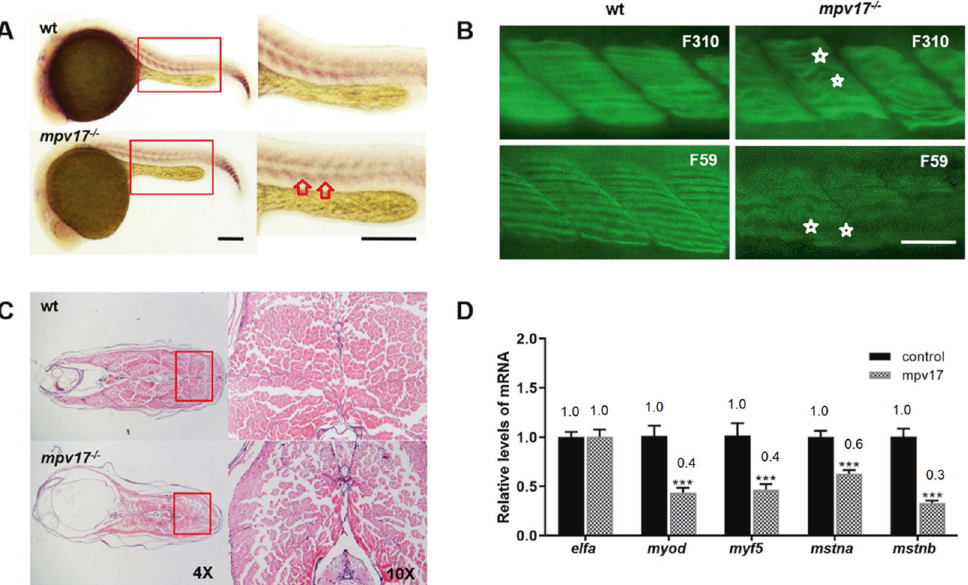
Fig. 3 The skeletal muscle showed defects during the development of the mpv17 − / − zebra fi sh. A In situ hybridization analysis of myogenic marker gene myod at 24 hpf. Scale bar = 250 μ m. B Confocal image of fast and slow muscle at 72 hpf. Antibodies F310 and F59 were used for staining the fast and slow muscle fi ber, respectively. Scale bar = 50 μ m. C Paraf fi n section and H&E staining analysis of the skeletal muscle structure in the 1-month-old fi sh. D The relative mRNA expression levels of the genes involved in the development of muscles.